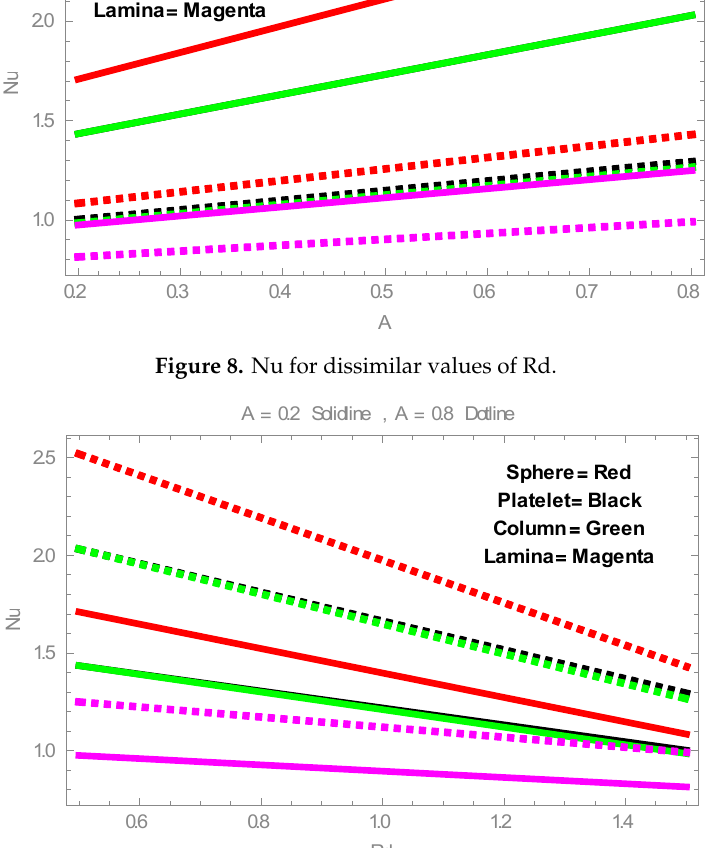
Figure 9. Nu for dissimilar values of (cid:1827).